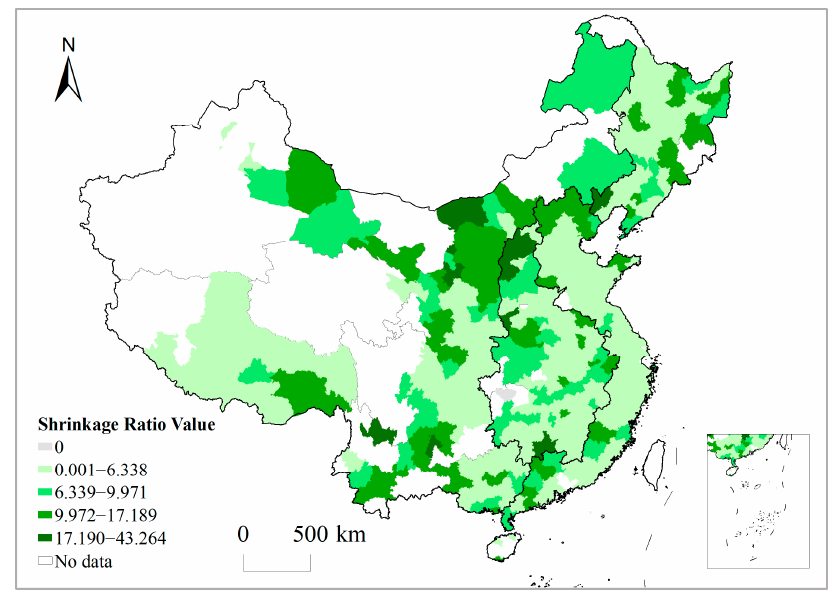
Figure 3. Spatial distribution of the degree of urban shrinkage.